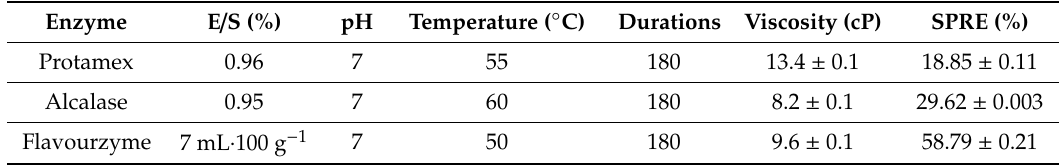
Table 1. Viscosity of soy protein hydrolysates using protease